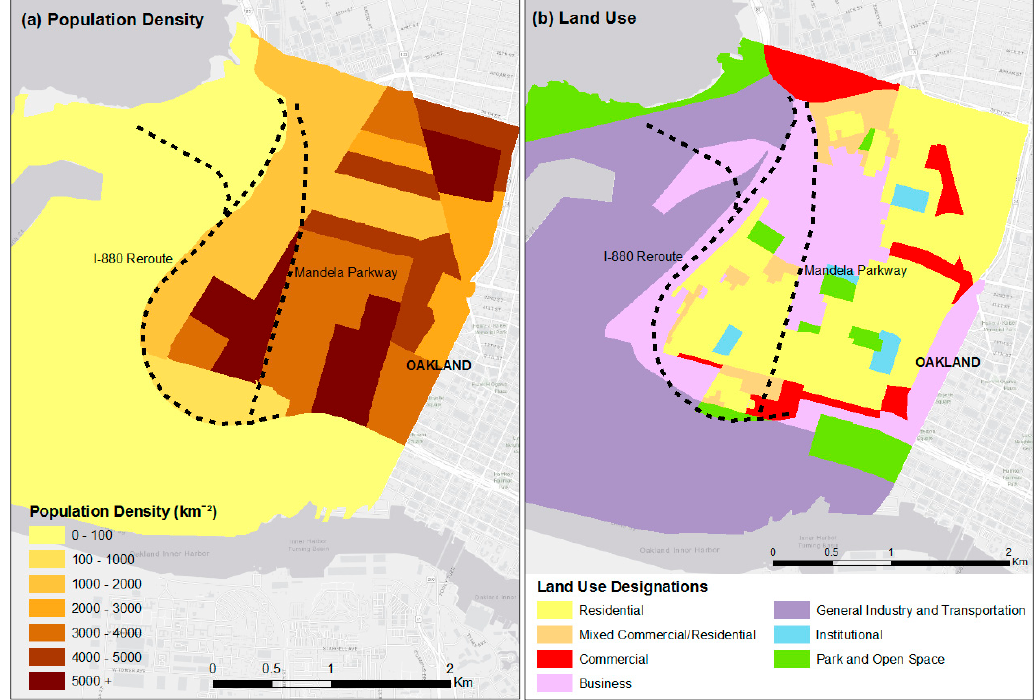
Figure 4. ( a ) Population density (people per km 2 ) in West Oakland in 2010. ( b ) Current West Oakland zoning land use designations. Dashed black lines represent the centerlines of the I-880 Reroute (left) and Mandela Parkway (right).